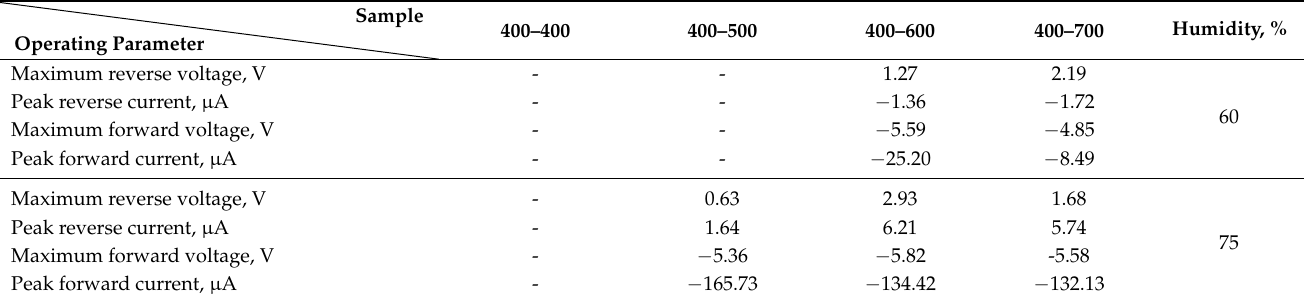
Table 1. Dependence of the Limiting Electrical Parameters of Heterojunctions on Humidity and Size of Contacting